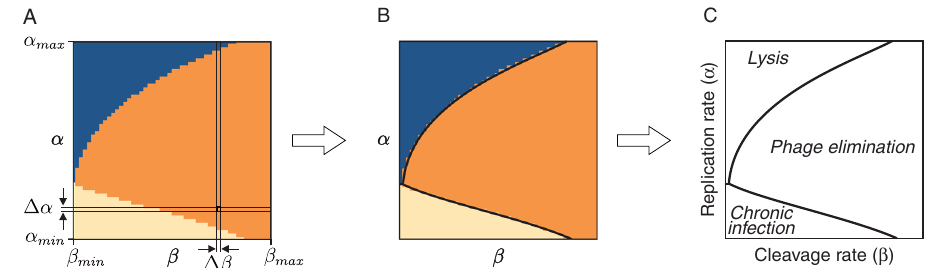
Fig.7|CharacterizationoftheinfectionspacefromthesimulationsofModel1. A Numericalsimulations of Model1 havethree possibleoutcomes:cell lysis (blue), control of the infection (orange), and chronic infection (light yellow). The simula- tionswereperformedforarangeofvaluesofparameters α and β ,fromaminimum ( α min and β min ,respectively)to amaximumvalue( α max and β max ,respectively)with